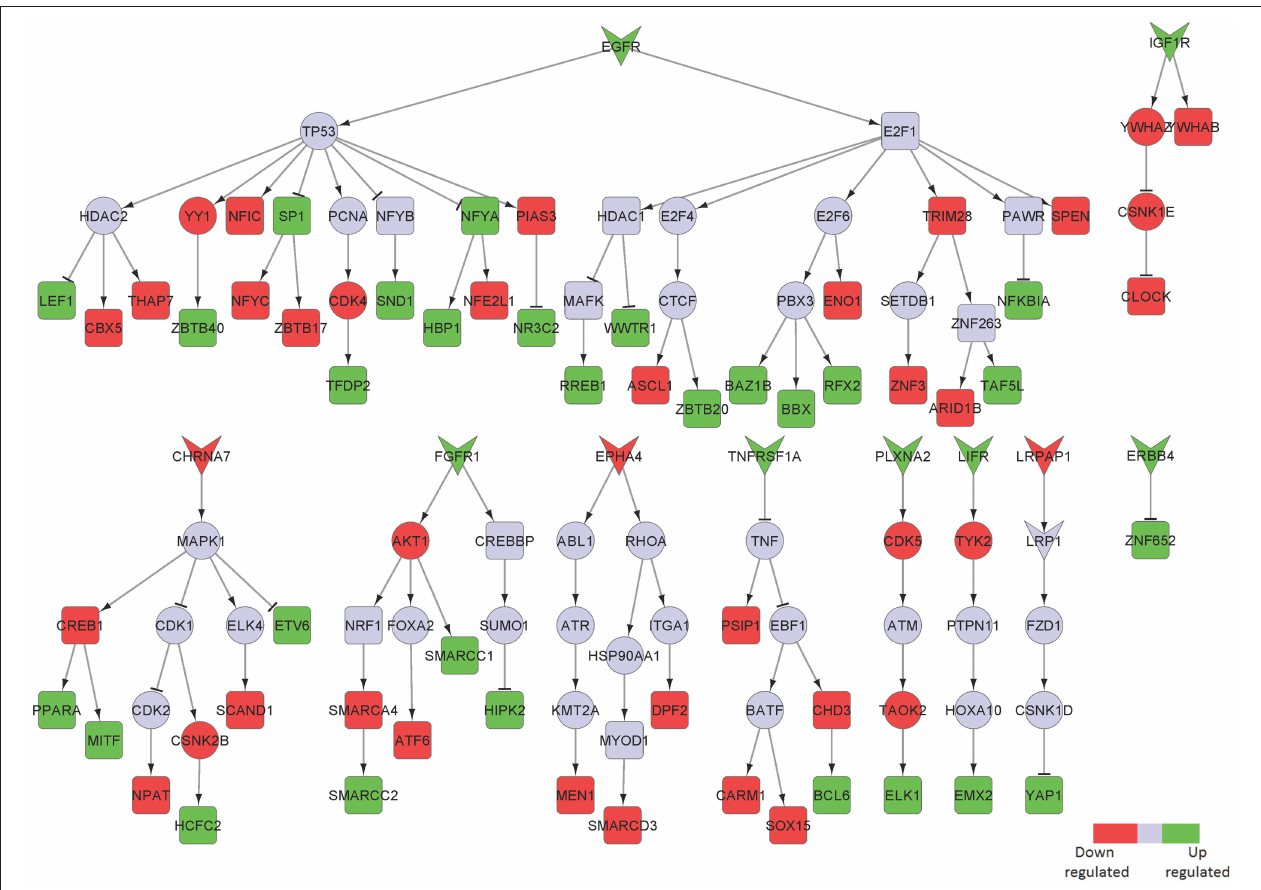
FIGURE 5 | Key signaling networks identified for the entorhinal cortex. The figure shows ten key signaling subnetworks controlled by EGFR, IGF1R, CHRNA7, FGFR1, EPHA4, TNFRSF1A, PLXNA2, LIFR, LRPAP1, and ERRB4 identified for entorhinal cortex with known role in AD. The signaling subnetworks controlled by EGFR, IFG1R, FGFR1, TNFRS1A, PLZNA2, LIFR, and ERBB4 represent constantly activated signaling, while the ones controlled by CHRNA7, EPHA4, and LRPAP1 represent constantly inhibited ones. Further, EGFR subnetwork was found regulate most of the differentially expressed TFs by controlling 16 upregulated and 12 downregulated TFs. The figure legends are the same as that in Figure 2 . Supplementary Figure 4 contains the other subnetworks identified for entorhinal cortex that did not have known role in